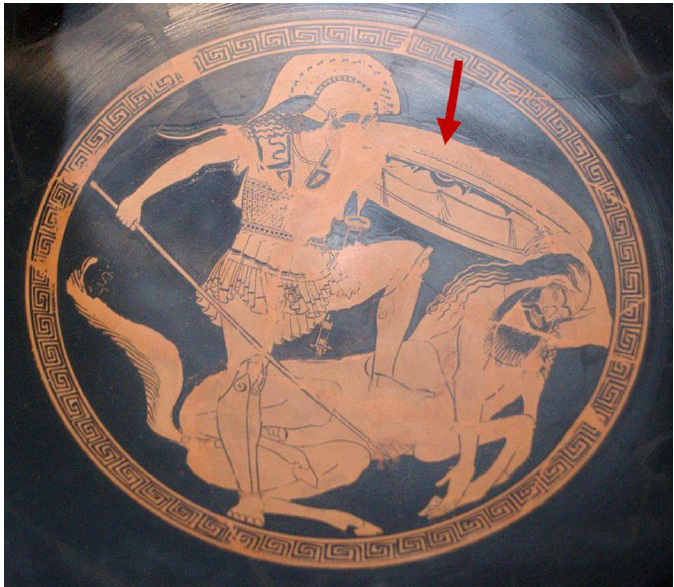
Figure 4. Hatching on the Lapith’s shield. Attic red-figure kylix by the Foundry painter. Munich, Antikensammlungen, 2640. Source: Wikimedia Commons.